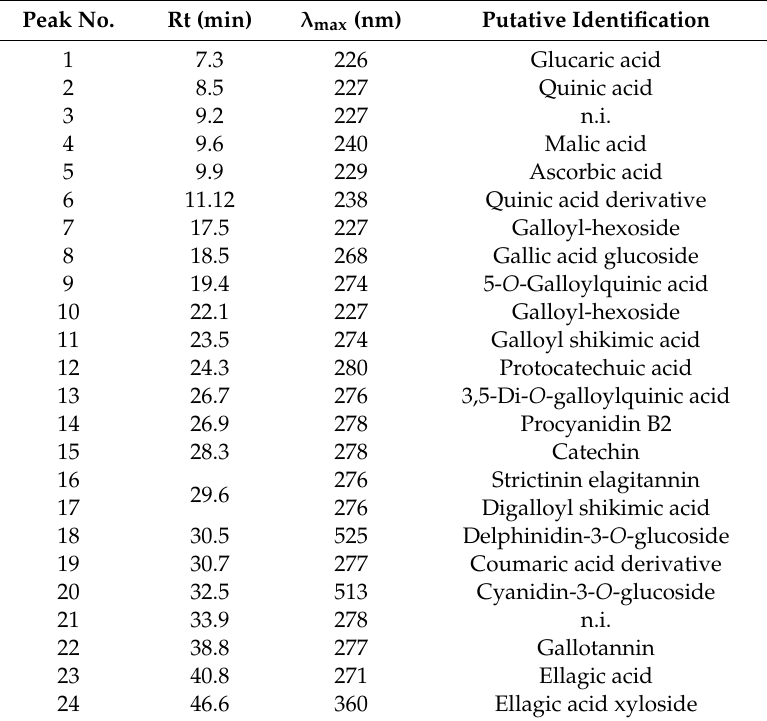
Table 2. Putative identification of compounds presented in the chromatograms and their corresponding retention time (Rt) and maximum absorption wavelength ( λ max